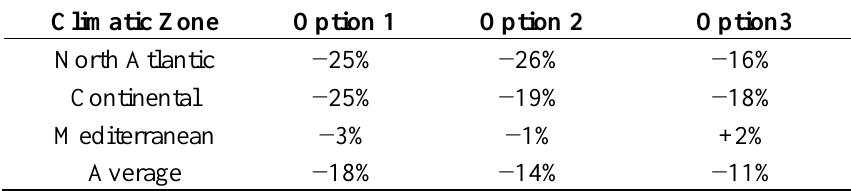
Table 10. Deviation between the different options and